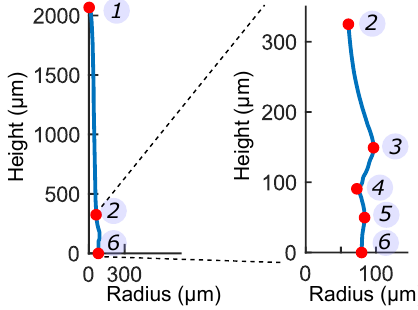
Figure 6. Characteristic Sections (1–6, red dots) are identified on one sensory hair. Magnified view of the hair base shown on the